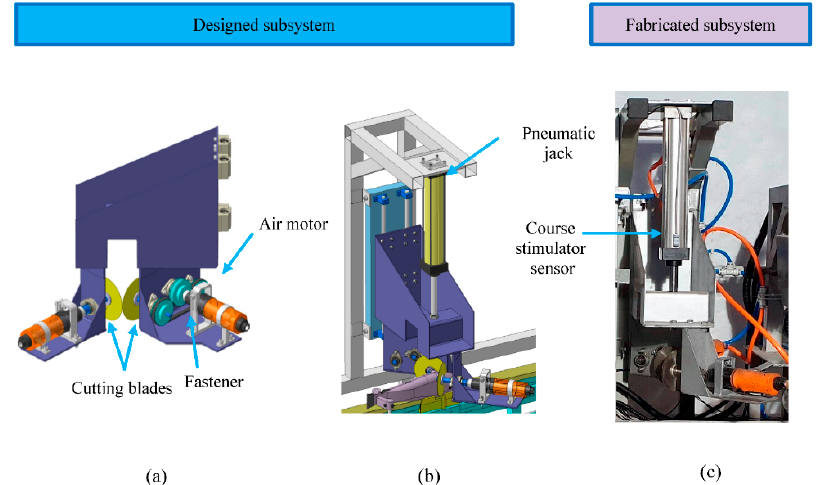
Figure 7. Head-cutting subsystem: ( a ) the position of the head-cutting subsystem in the machine, ( b ) isometric view of the subsystem, and ( c ) right view of the subsystem.